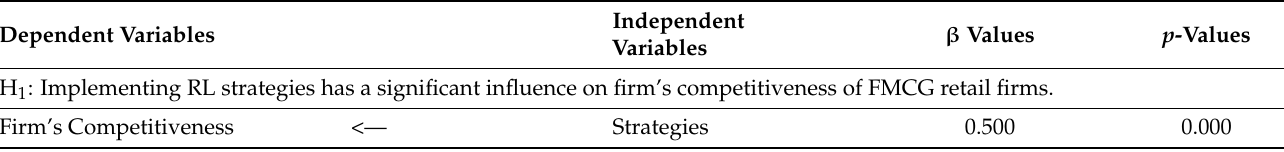
Table 11. Standardised regression weights and H 1